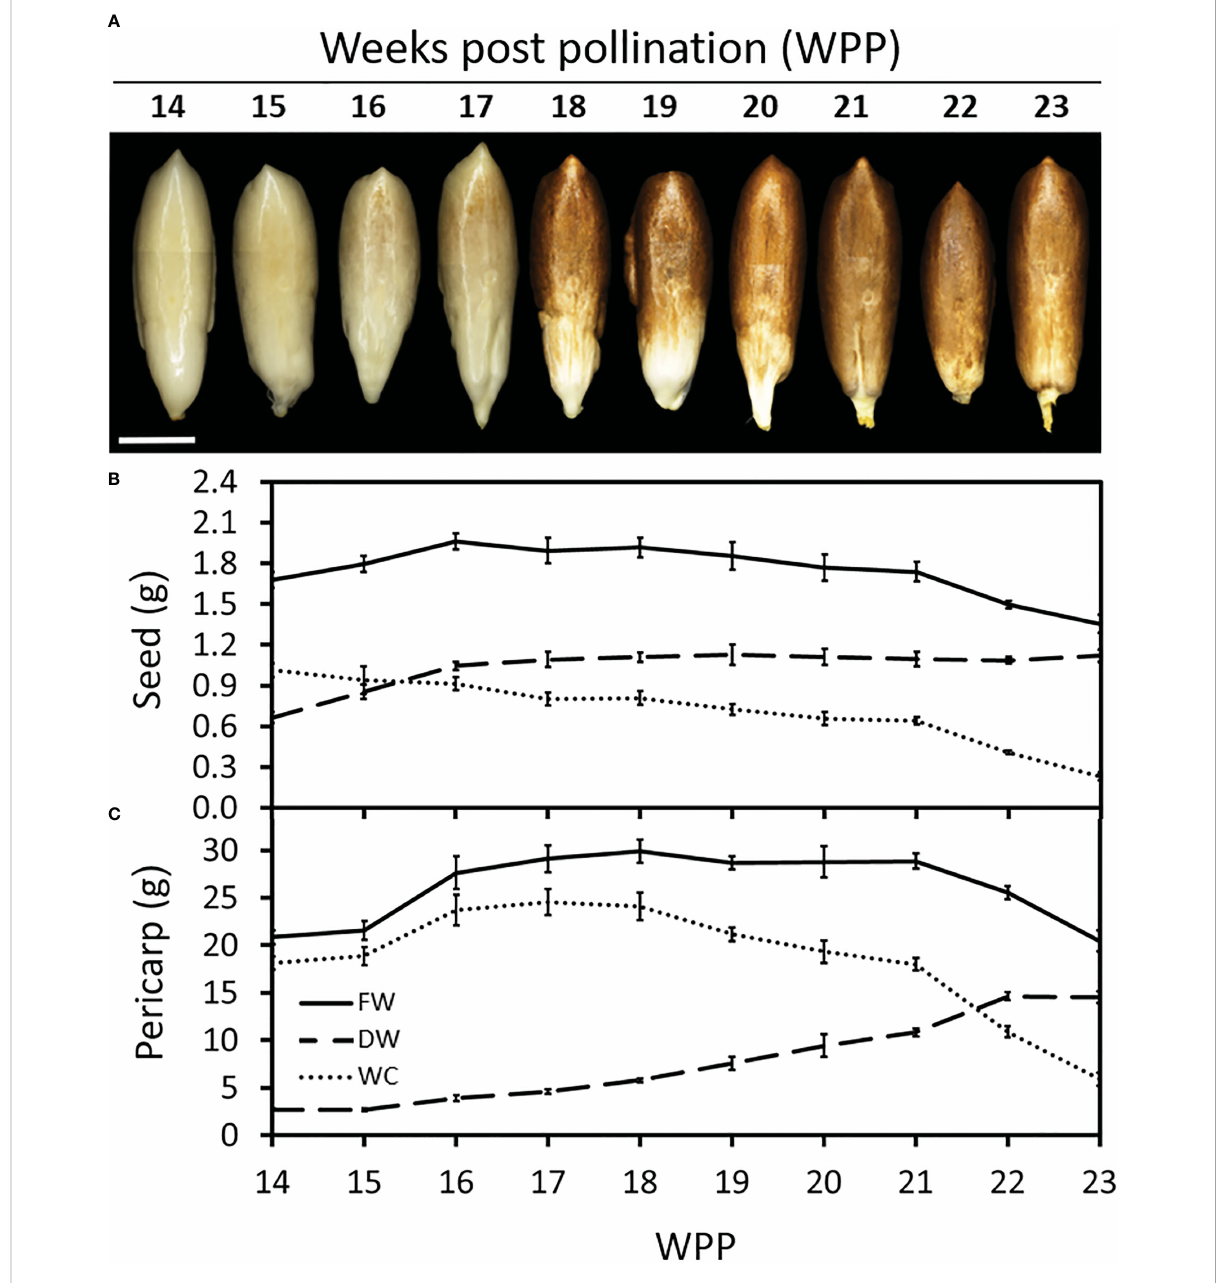
FIGURE 2 Date palm seed and fruit development. Representative fruits were sampled and seeds were separated from the pericarp tissue (Gro fi t 2017). (A) Seeds were photographed at different stages in fruit development as indicated by number of weeks post pollination (WPP). Dry weight (DW) and water content (WC) were quanti fi ed for both (B) seed and (C) pericarp. Note the substantial reduction in WC, in both seed and fruit pericarp, starting from 21 WPP. Error bars indicate standard error. Scale bar: 1 cm. The number of fruit measured at each time point was